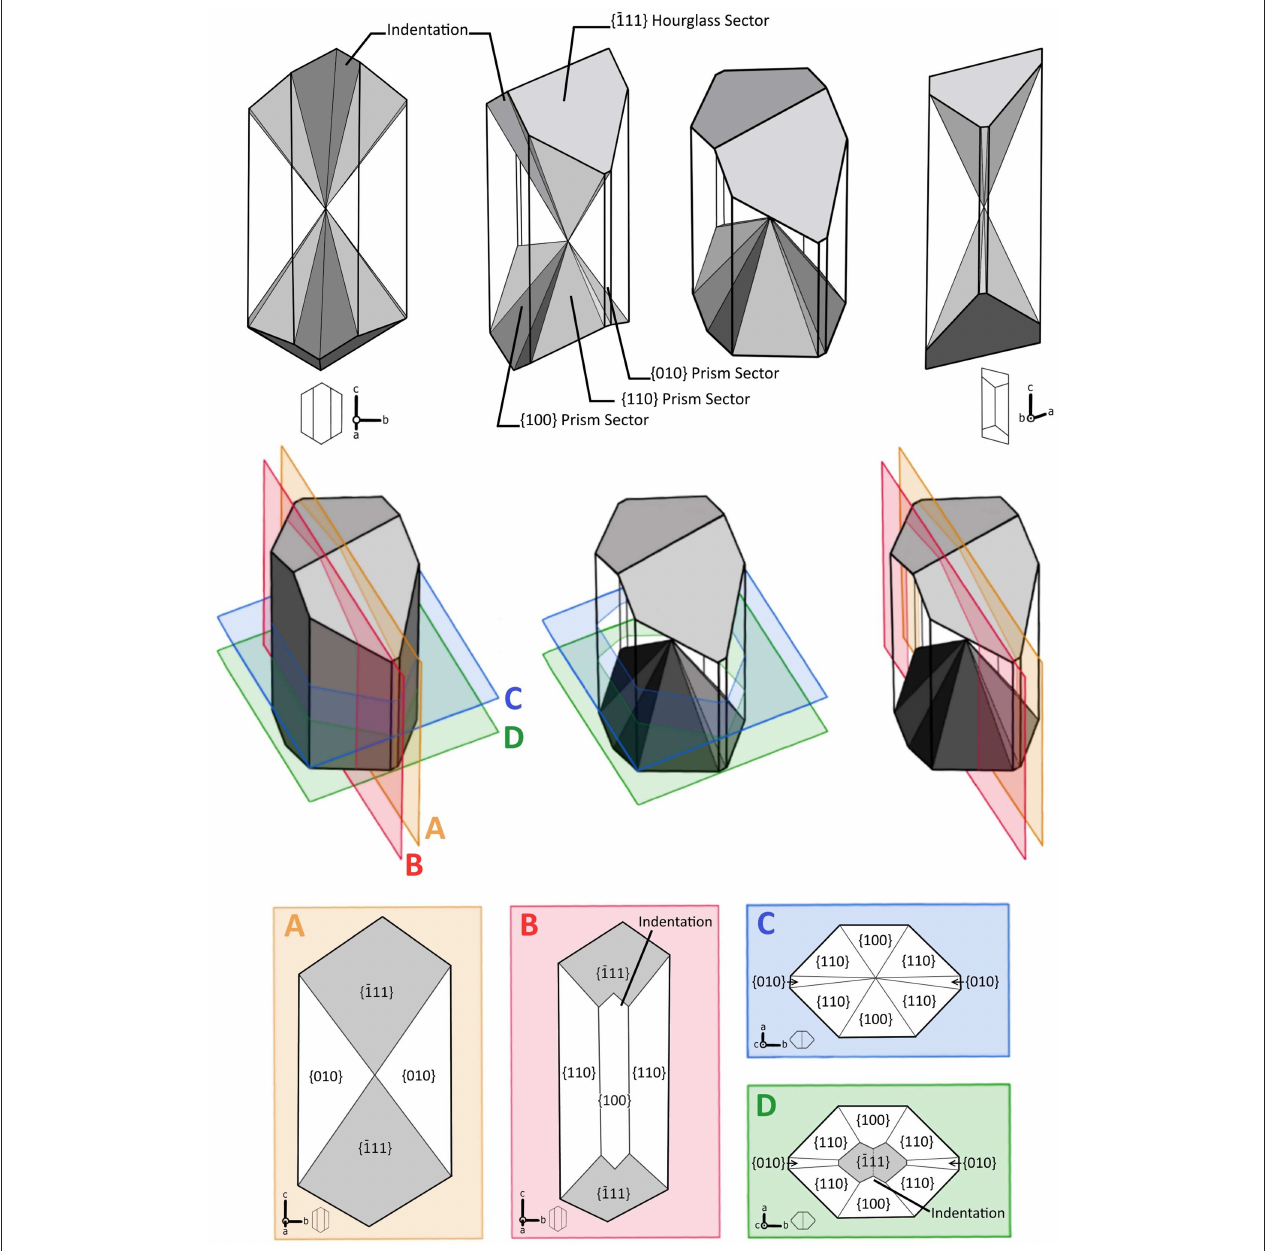
FIGURE 3 | Crystal model based on the habit of sample 31 ( Figure 2 ) and following the 12-pyramid morphological model of augite (e.g., Downes, 1974; Leung, 1974; Ubide et al., 2019). The crystal is composed of a total of 12 pyramidal sectors: 8 prism sectors growing perpendicular to the c -axis, including the forms {100} x2, {110} x4, and {010} x2, plus 4 hourglass sectors of the form { − 111} growing along the c -axis. The bottom panel shows theoretical sections along and across the c -axis, which expose the prism and hourglass sectors in markedly different locations and shapes. The sections along the c -axis are orthogonal to those shown in Ubide et al. (2019): in the present study, elongated sections were prepared along the c-b -axes, as opposed to the a-c -axes in Ubide et al. (2019). Note that the angular outline of the hourglass form, generating “valleys” that translate into “indentations” of sector { − 111} in two-dimensional crystal